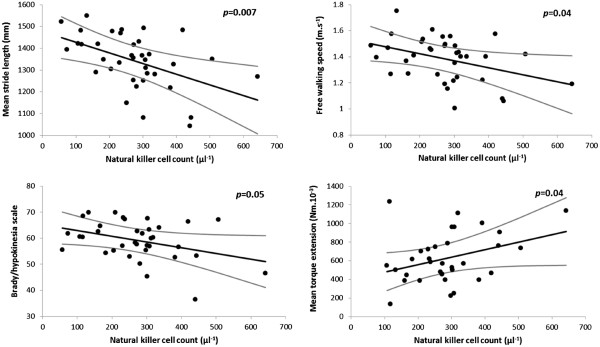
Relationship of brady/hypokinesia and flexor-rigidity to natural-killer count in core group, after adjustment for demographic characteristics and, in the case of flexor-rigidity, for T-helper count. (Standardised, as appropriate, to no background medication, age 65 years, height 1.7 m, time since diagnosis 6 years, T-helper count 1000 μl-1.) Regression line and 95% CI are shown for stride-length, free-walking-speed, the brady/hypokinesia scale and flexor-rigidity on natural-killer count. Although all values for a longitudinal outcome were used to estimate regression lines, the points shown are the average per person. (Brady/hypokinesia scale: 0 = marked impairment on video, 100 = none).